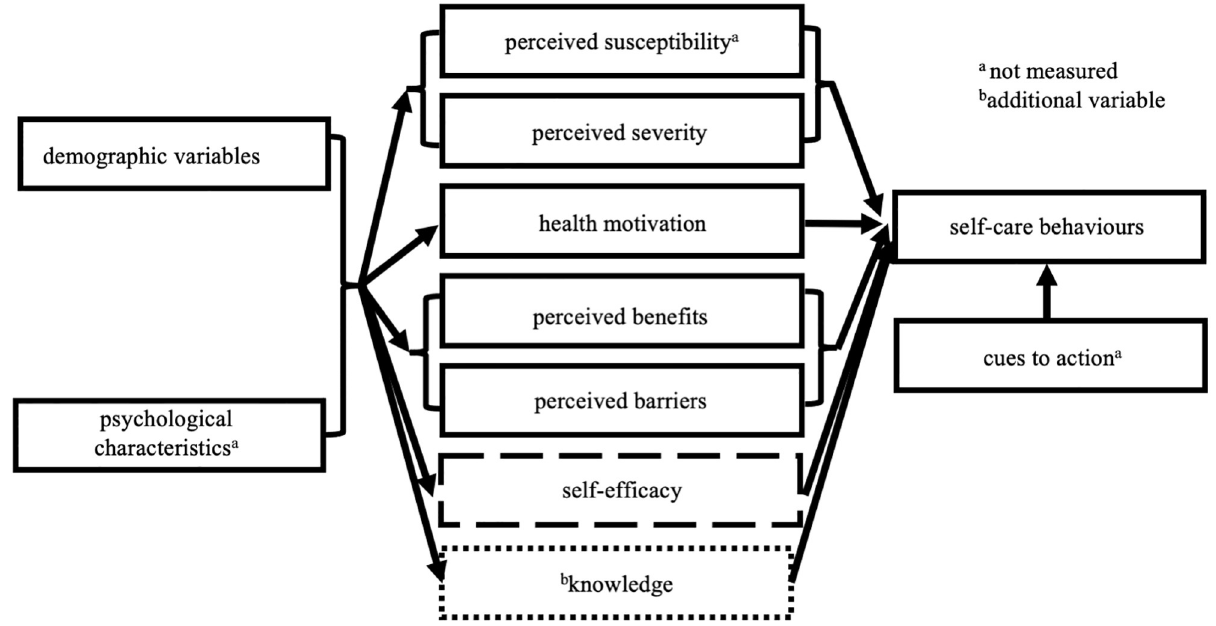
Fig 1. A version of the Health Belief Model (HBM) in adopting hypertension self-care behaviours in the present study. Self-efficacy was added to the model in the mid-1980s and so is illustrated by a dashed line. Knowledge was hypothesized to be an additional variable in influencing self-care behaviour due to its association with blood pressure control in our